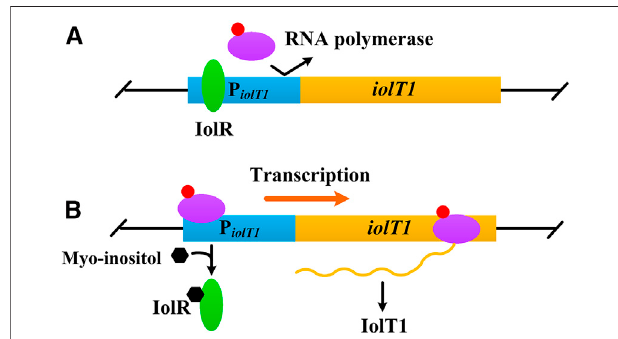
FIGURE 1 | Negative control of iolT1 transcription. (A) No myo-inositol. The repressor IolR binds to the promoter of iolT1 (P iolT1 ) and blocks RNA polymerase from transcribing the iolT1 . (B) With presence of myo-inositol. Myo-inositol as an inducer binds to the repressor IolR, resulting in its dissociation and allowing RNA polymerase to transcribe the iolT1 .